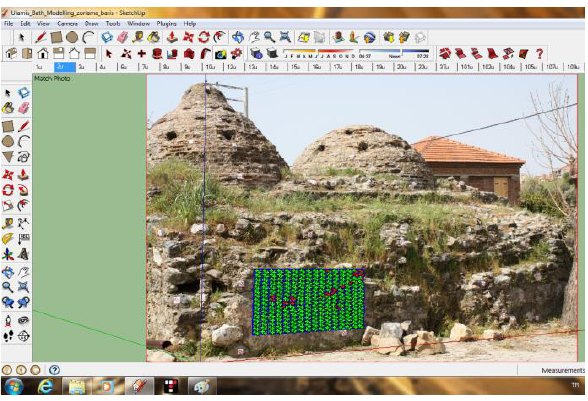
Figure 9. Up sampling of a mesh group